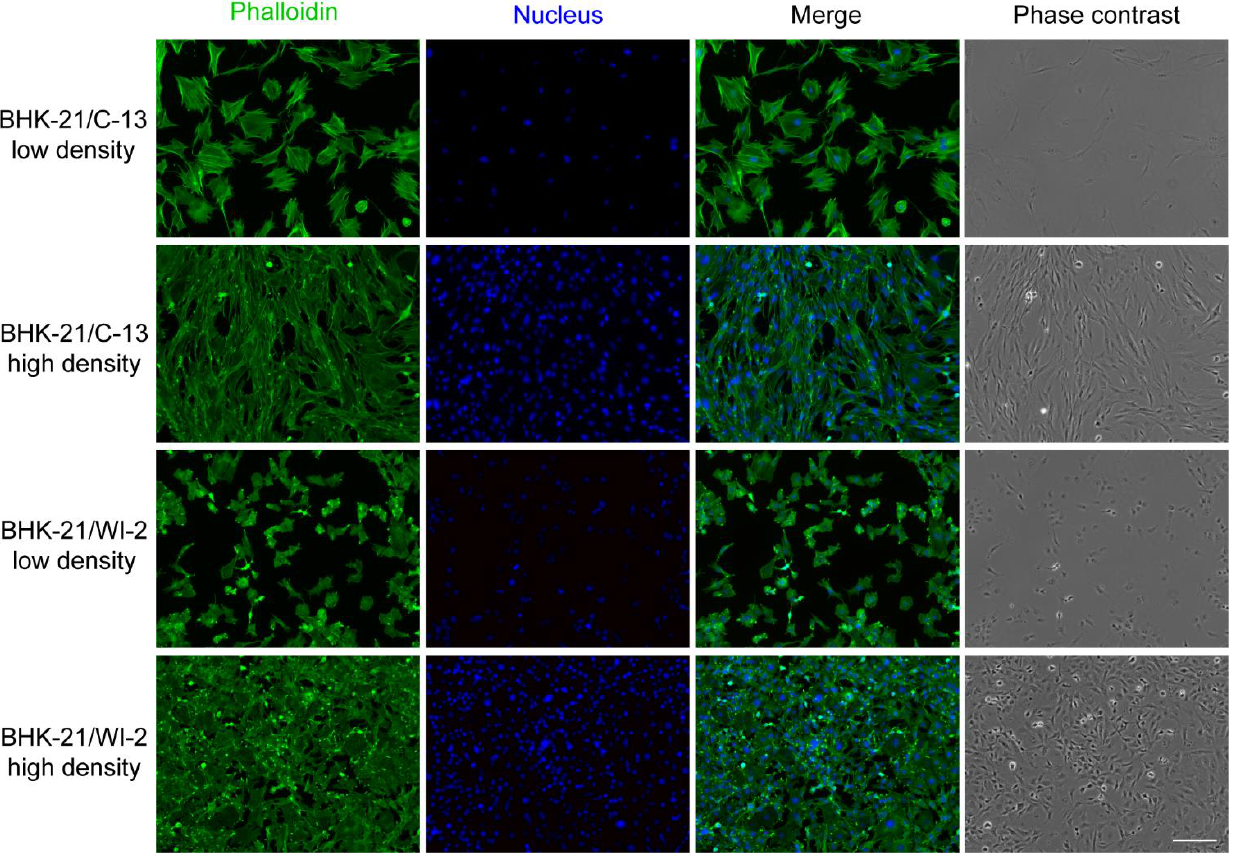
Figure 2. Morphology of BHK-21/C-13 and BHK-21/WI-2 cells. BHK-21/C-13 or BHK-21/WI-2 cells were seeded at low or high density, cultured for 24 h, and stained for actin with phalloidin (green) and for DNA with Hoechst (blue). Cells were imaged by fluorescence microscopy. Scale bar =150 µm.